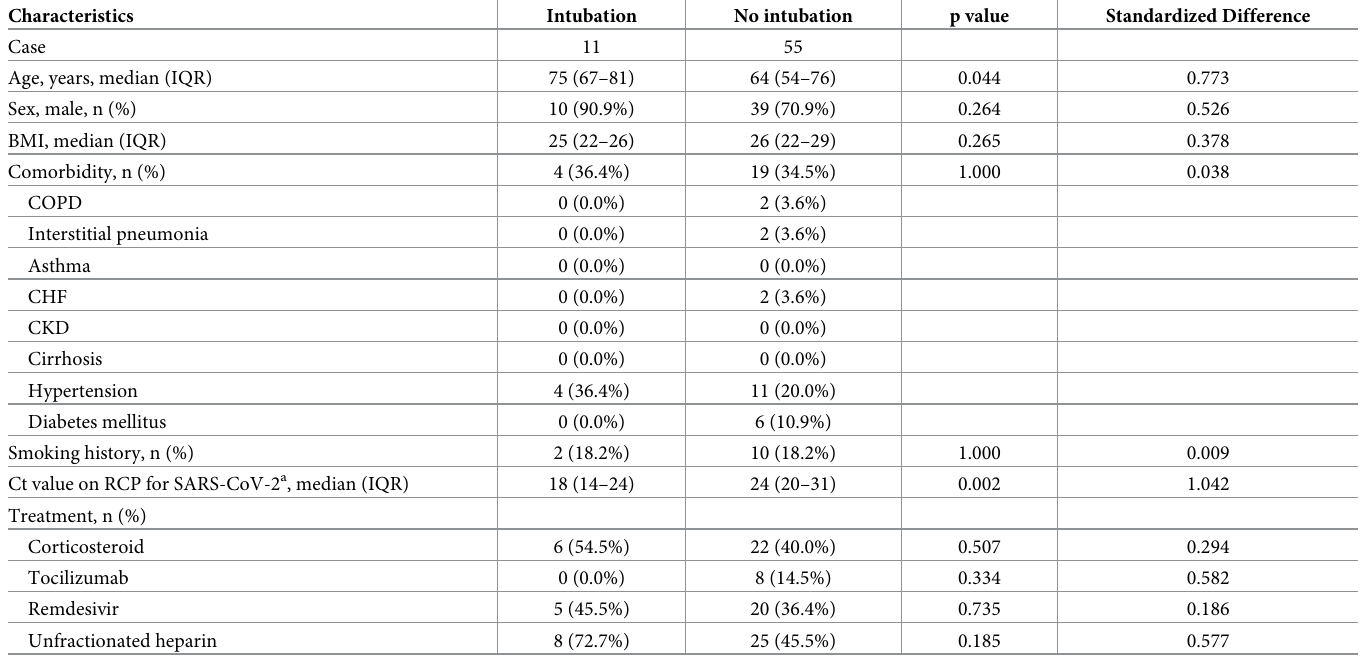
Table 1. Characteristics of patients with COVID-19 on oxygen therapy.